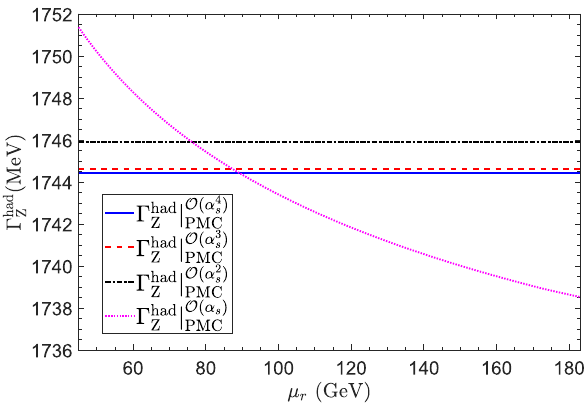
Fig. 2 The Z -boson hadronic decay width (cid:4) had under the PMC scale- Z setting approach versus the renormalization scale μ r . The dotted, the dashed-dot, the dashed and the solid lines are for the predictions up to ) , O (α 2 ) , O (α 3 ) , O (α 4 ) order levels, O (α s s s s